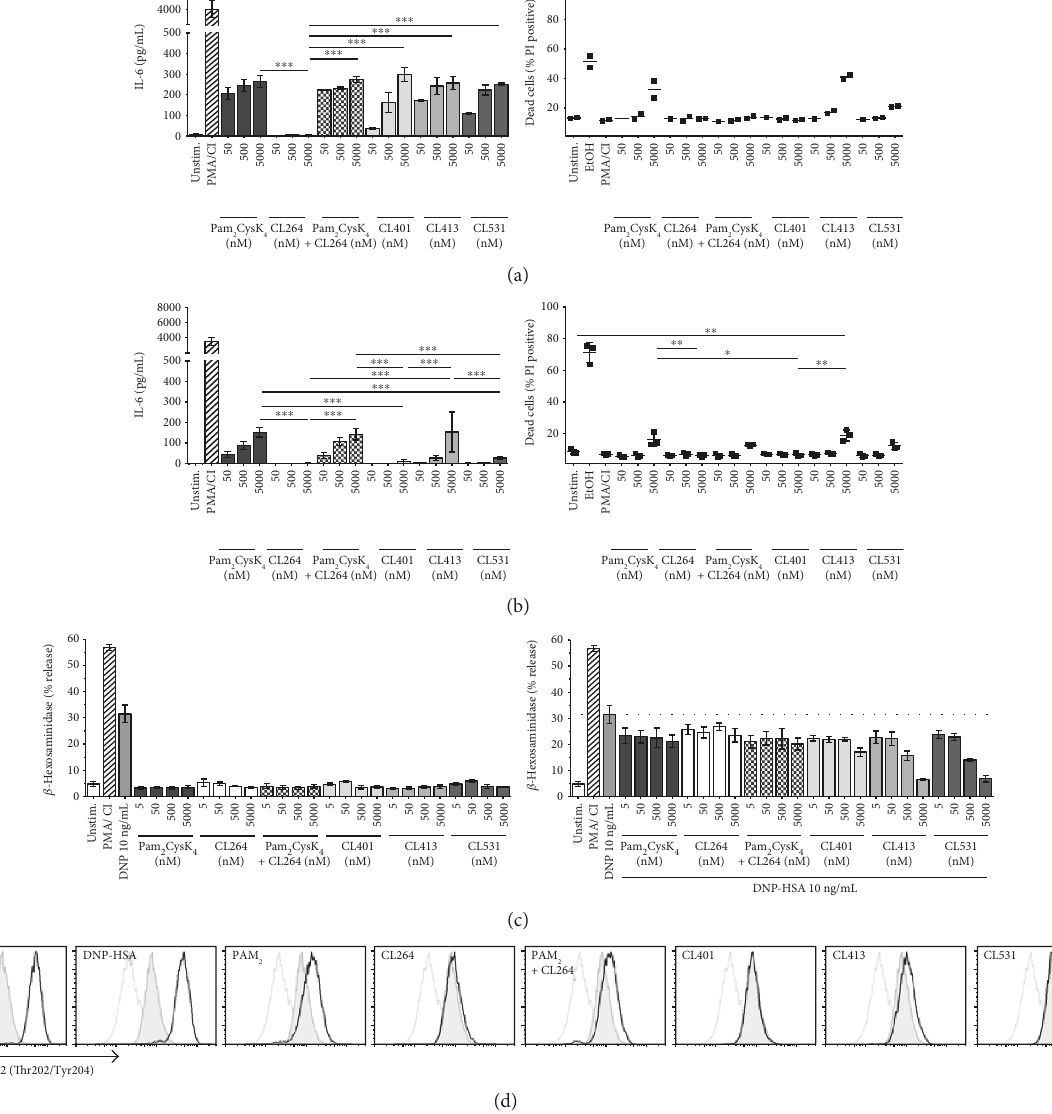
Figure 3: Dual TLR2/7 ligands induce limited mast cell activation directly but suppress IgE-and-antigen-induced mast cell degranulation. IL-6 secretion and cytotoxicity of stimulated BALB/c (a) and C57BL/6 (b) BMCMCs. TLR2/7 ligand-induced degranulation in the presence or absence of DNP-HSA from α DNP-IgE-sensitized C57.1 MCs. Dashed line indicates the level of β -hexosaminidase release induced by stimulation with 10ng/mL DNP-HSA alone (c). Analysis of phospho-ERK1/2 (Thr202/Tyr204) levels in C57BL/6 BMCMCs stimulated with 5 μ M of the di ff erent TLR ligands for 5min (d). Grey: unstained cells; grey tinted: unstimulated; black: stimulated as indicated; Data are representative results of two (d) or mean of three (a, b, c) independent experiments ± SD. ∗ P < 0 05 ; ∗∗ P < 0 01 ; ∗∗∗ P < 0 001